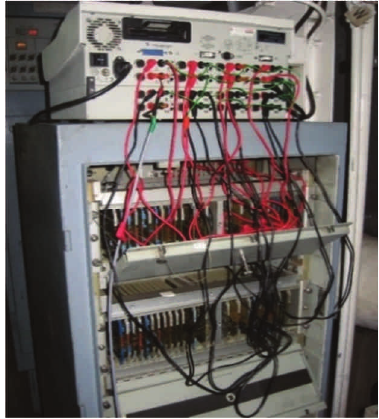
Fig. 3. The measuring-recording system during the measurement Parameters were recorded in units of the imperial sys- tem of measurement (United States Customary System Units), since in such units measure the measuring